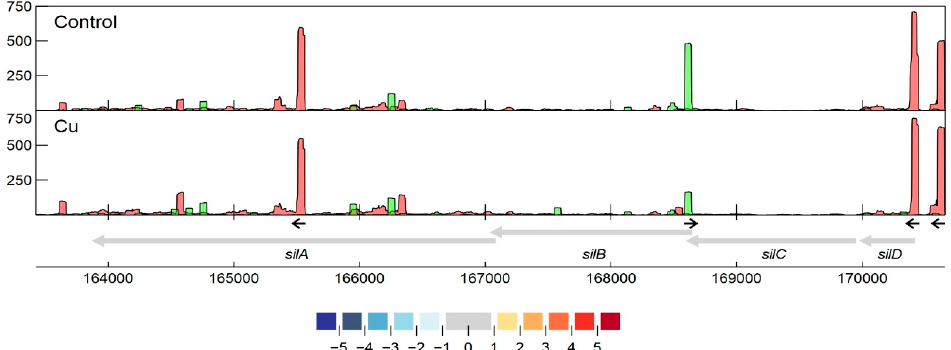
Figure 6. Transcription profile analysis of the sil cluster from C. metallidurans CH34 when exposed to copper. Combined TSS read counts of the three biological replicates for control (upper) and Cu condition (lower) are shown for positive (green) and negative (red) strands. CDSs related to the sil cluster (coordinates for the pMOL30 region shown at the bottom) are colored based on their log 2 fold change. The small black arrows indicate clearly identified primary and internal TSSs.